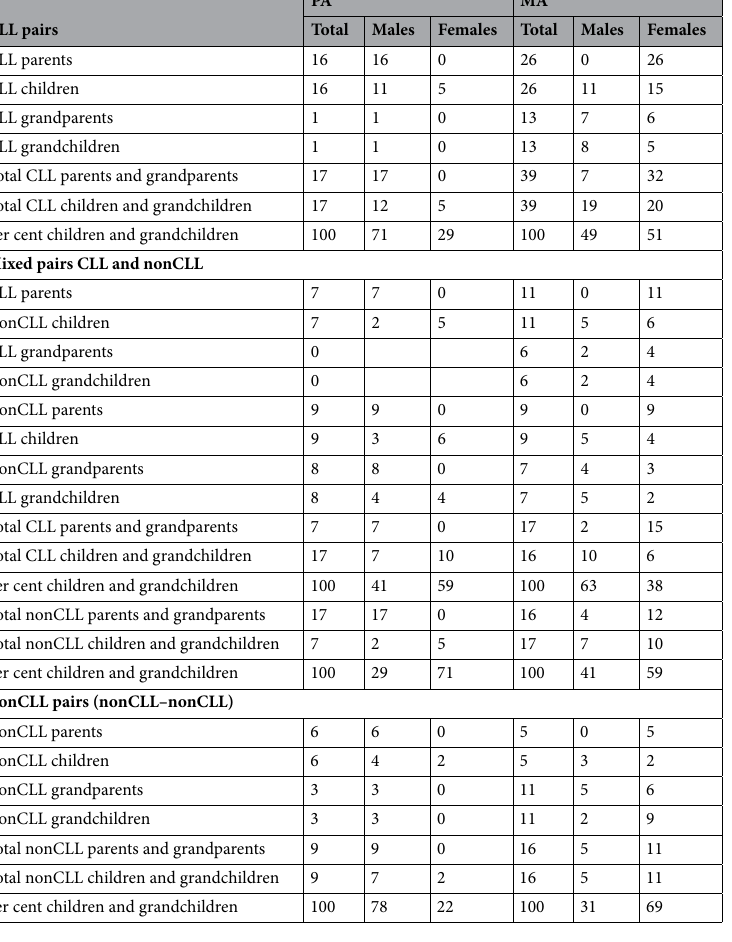
Table 2. Paternal (PA) and Maternal (MA) affiliation of affected parent – offspring in pairs from families in Norway and Denmark with unrelated